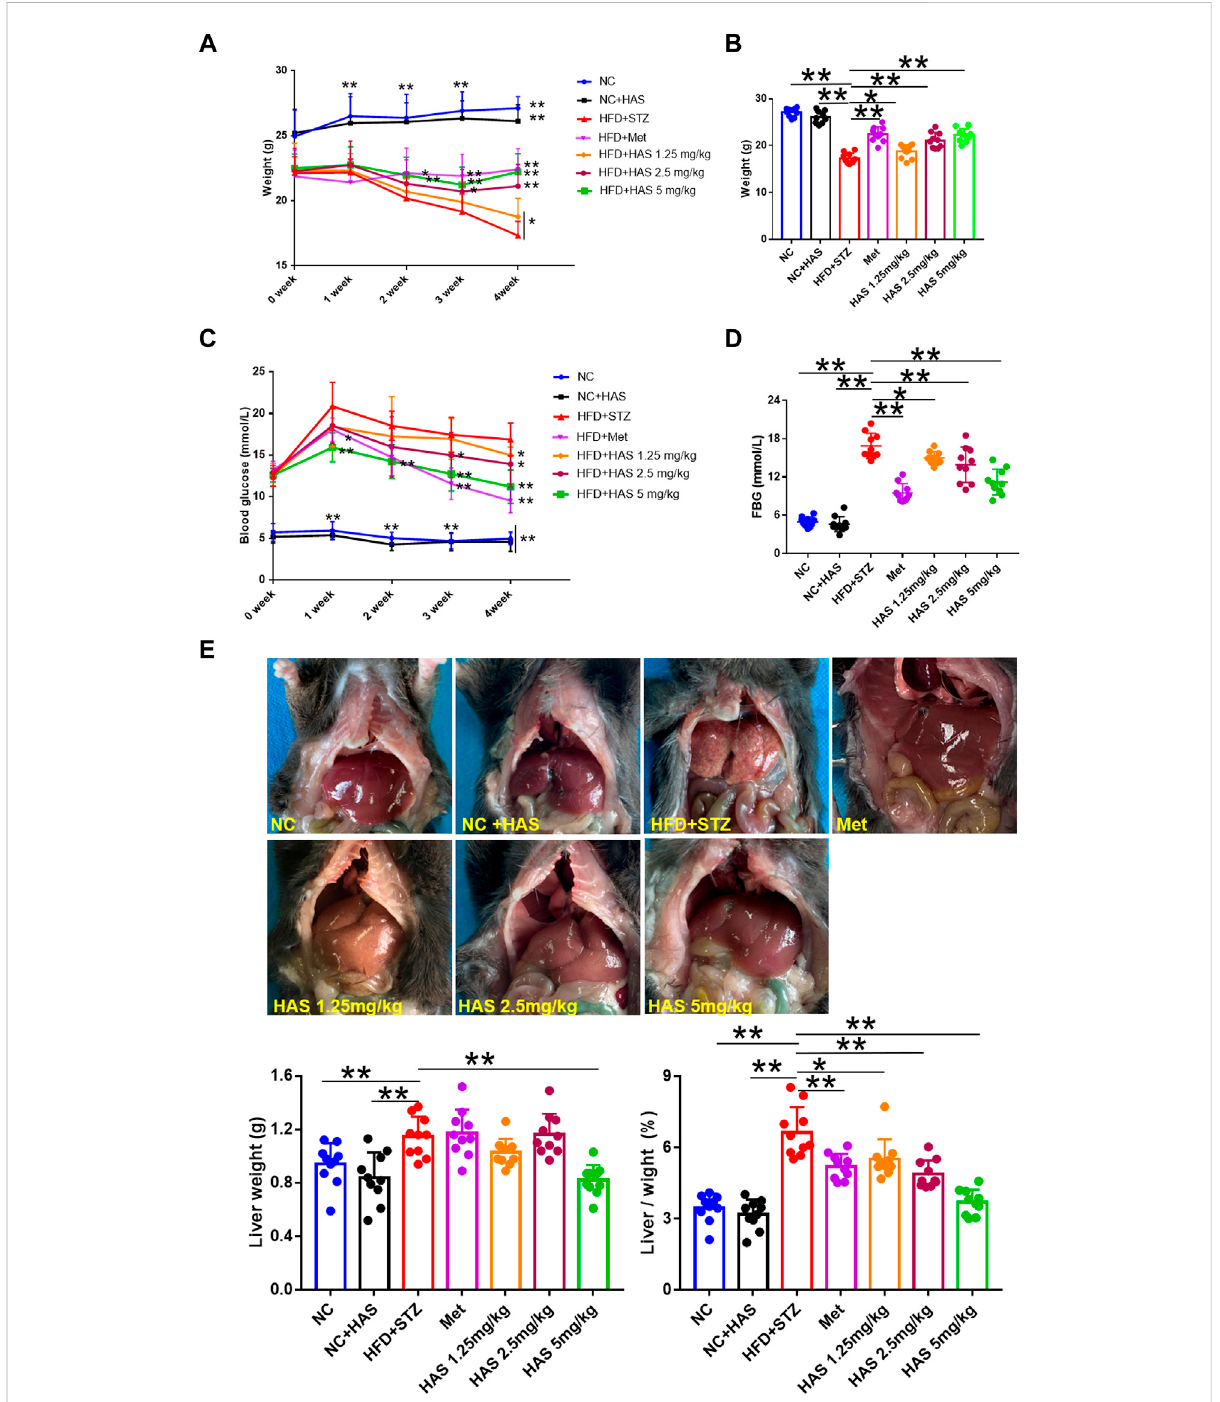
FIGURE 1 Effects of HAS on HFD + STZ mice. (A,B) HAS treatment resulted in increased body weight of HFD + STZ mice. (C,D) HAS treatment resulted in decreased fasting blood glucose in HFD + STZ mice. (E) Representative image of the liver of mice in different treatment groups; HAS treatment reducedliverweightandliverindexinHFD+STZmice.Thedosesof2.5,5.0,and10 mg/kgindicatelow,middle,andhighdosesofHAS,respectively, and the dose of Met was 150 mg/kg. Data are expressed as mean ± SD ( n = 10), ** p < 0.01 vs. HFD + STZ